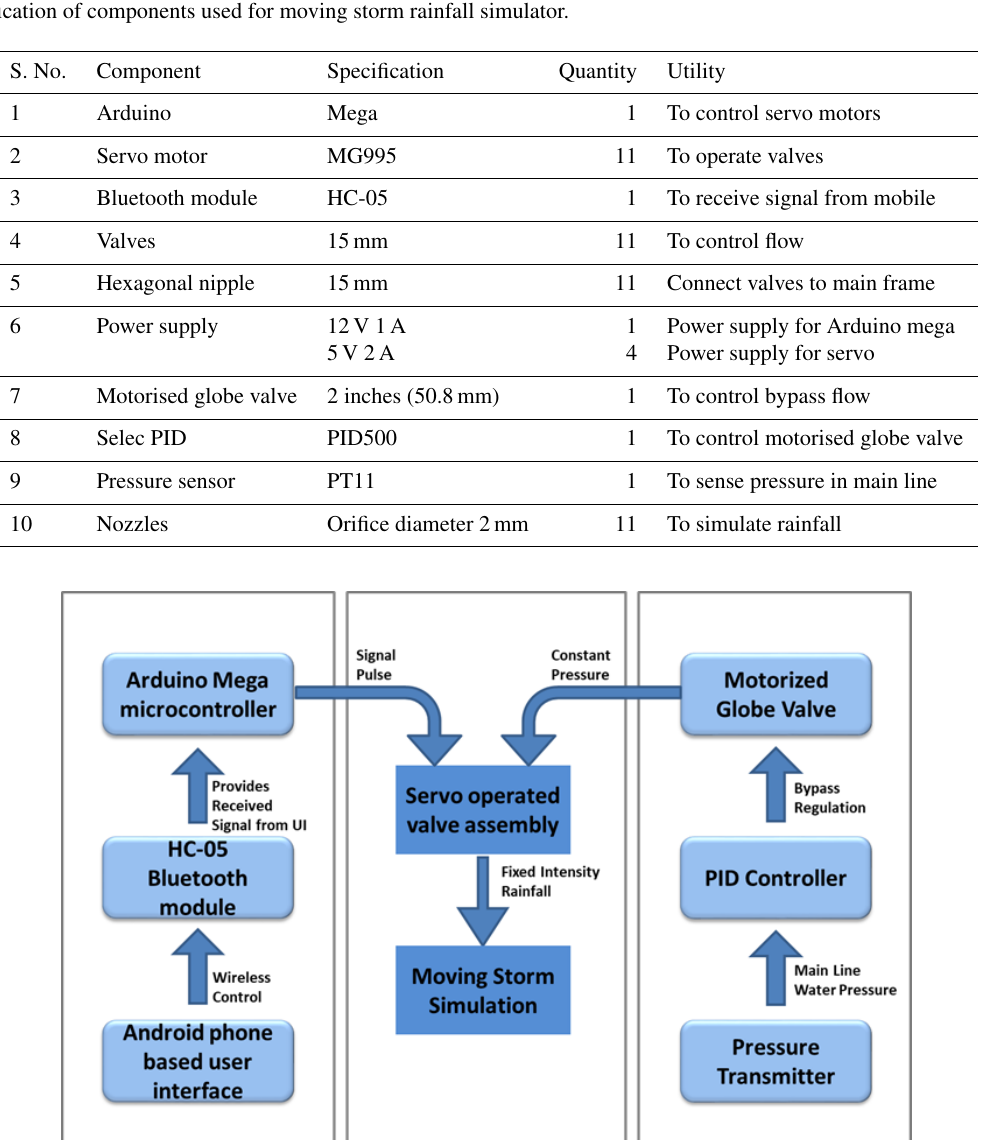
Figure 3. The operational structure of moving storm rainfall